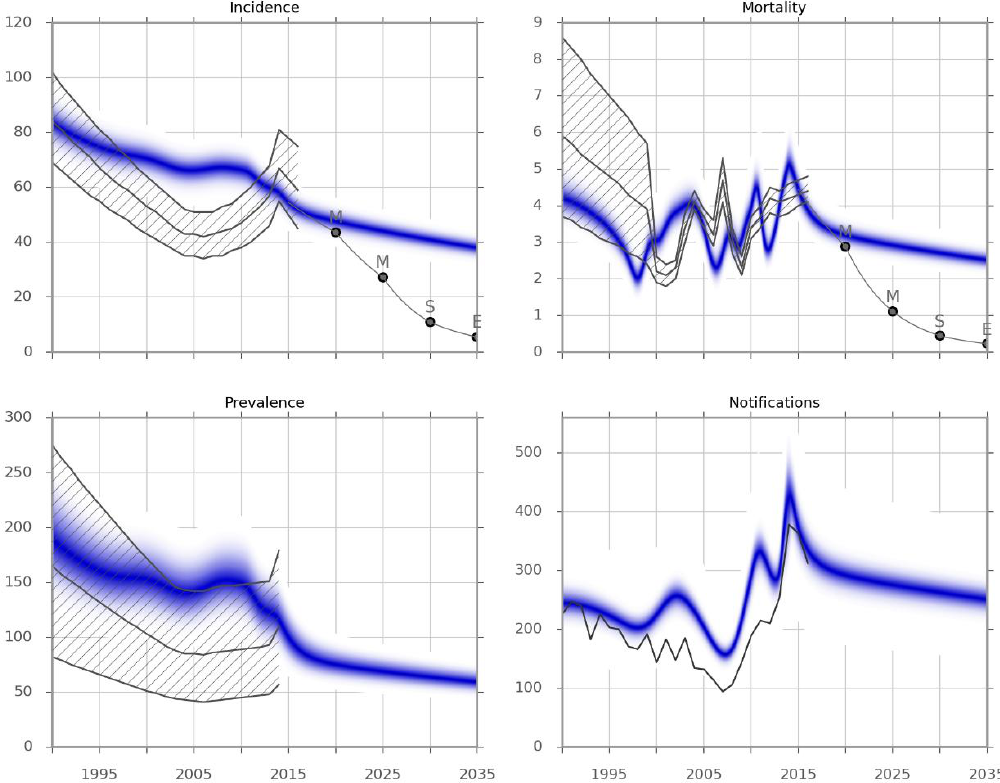
Figure 1. Model calibration results. Incidence and observed mortality (per 100,000 per year), prevalence (per 100,000) and the number of notifications by calendar year. The blue-shaded areas represent the calibrated model predictions obtained from the Metropolis simulation. The grey lines represent point estimates, and the hatched areas represent the confidence limits for each indicator from the Global TB Report 2017. The light grey line indicates the epidemic trajectory that would be required to achieve the different targets, and is a piecewise exponential function. M, Milestone; S, Sustainable Development Goal; E, End TB Strategy Target.